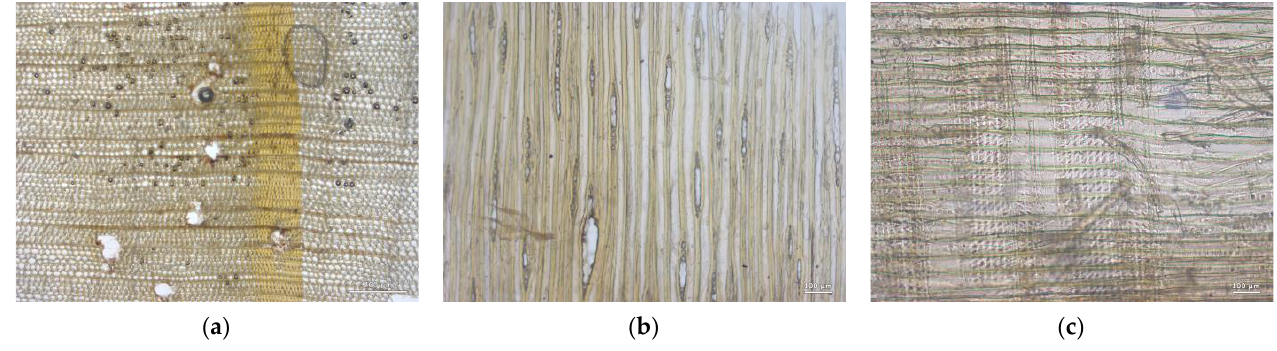
Figure 20. Characteristic sections identified as belonging to the species Pinus pinaster Aiton: ( a ) Cross-section of sample OU1; ( b ) Tangential section of sample OU1; ( c ) Radial section of sample OU2.